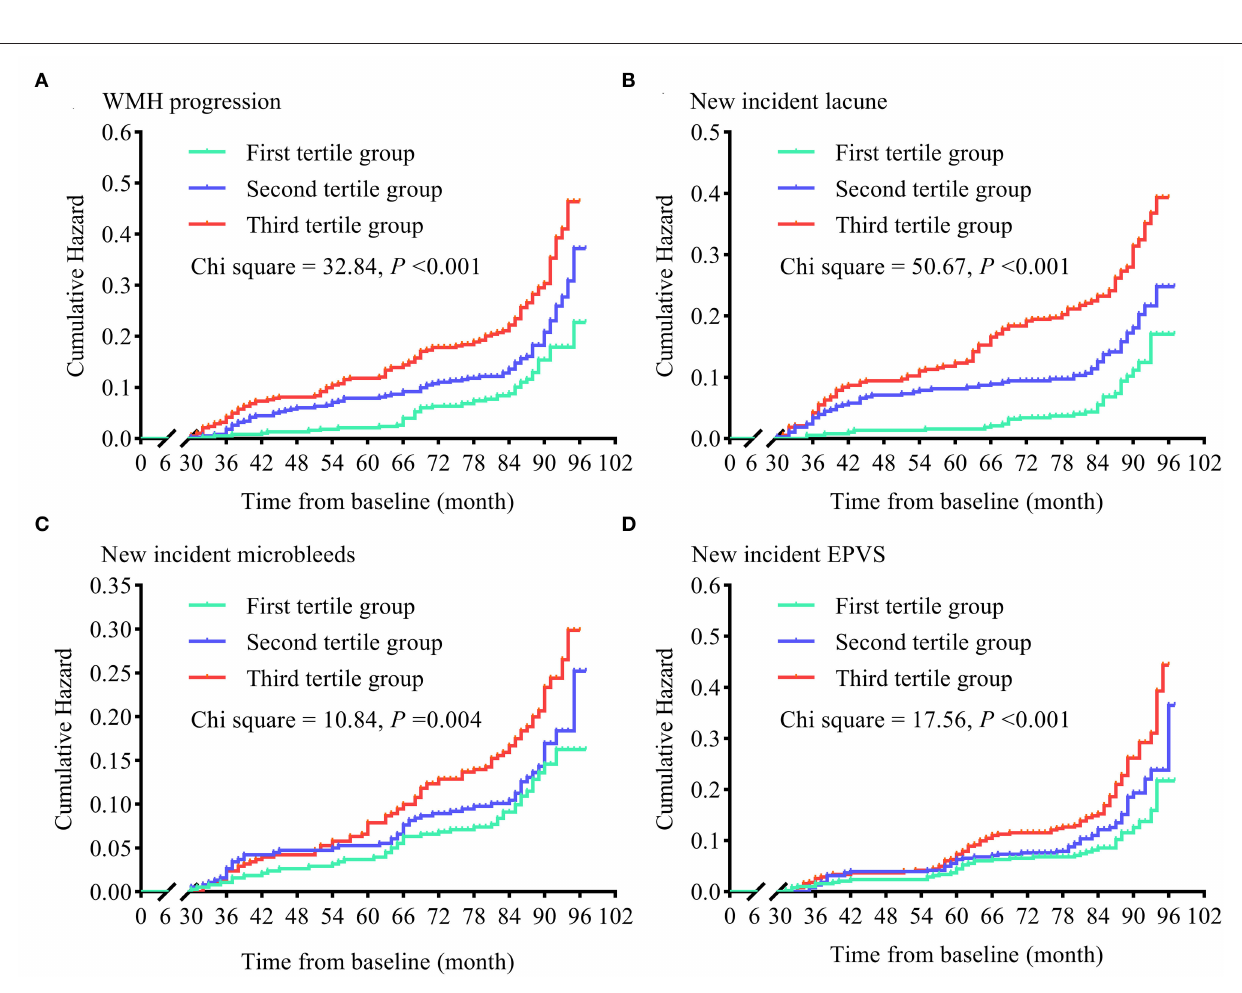
Frontiers in Neurology |